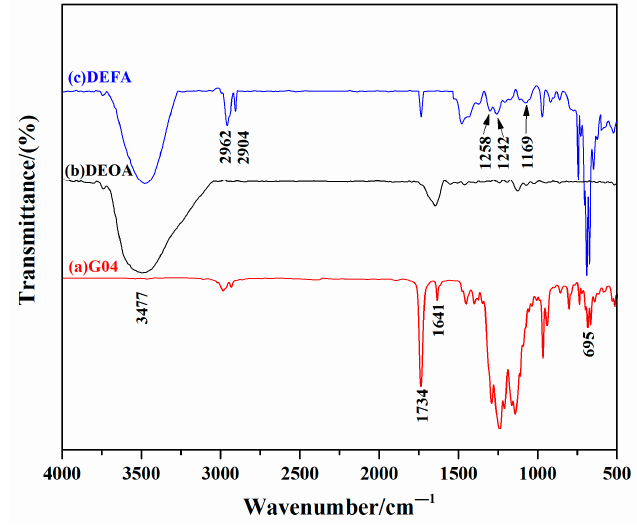
Figure 1. IR spectra of ( a ) fluorine-containing monomer (G04), ( b ) diethanolamine (DEOA) and ( c ) fluorinated chain extender DEFA.